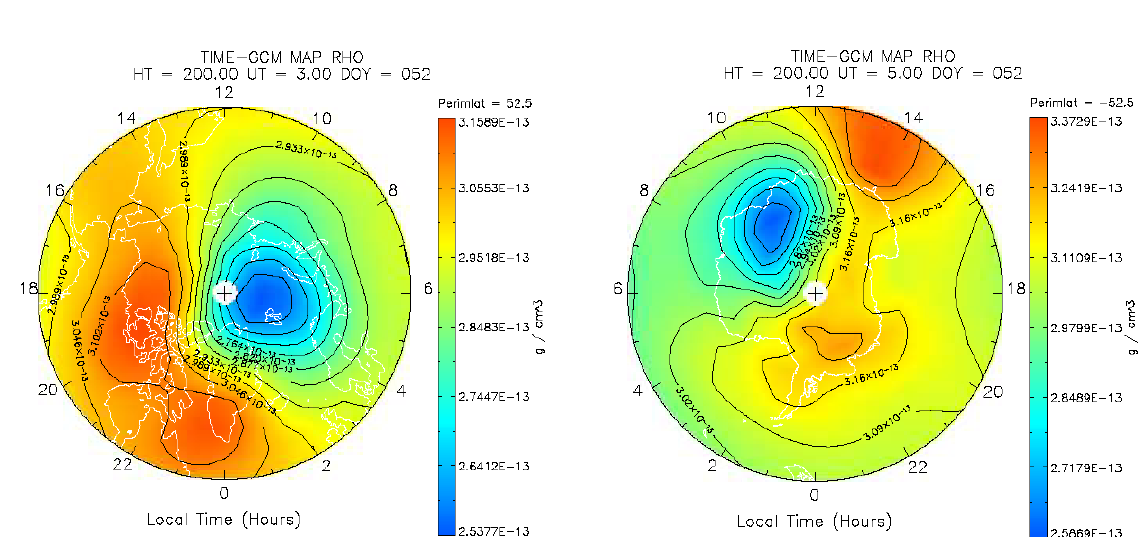
15:00 LT–02:00 LT, while in the Southern Hemisphere they circle the pole during the day, just as the minimum